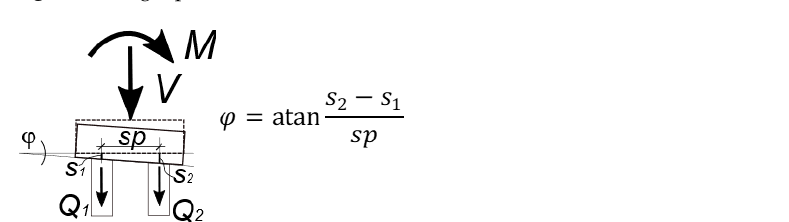
Figure 8. Single pile settlement curves.